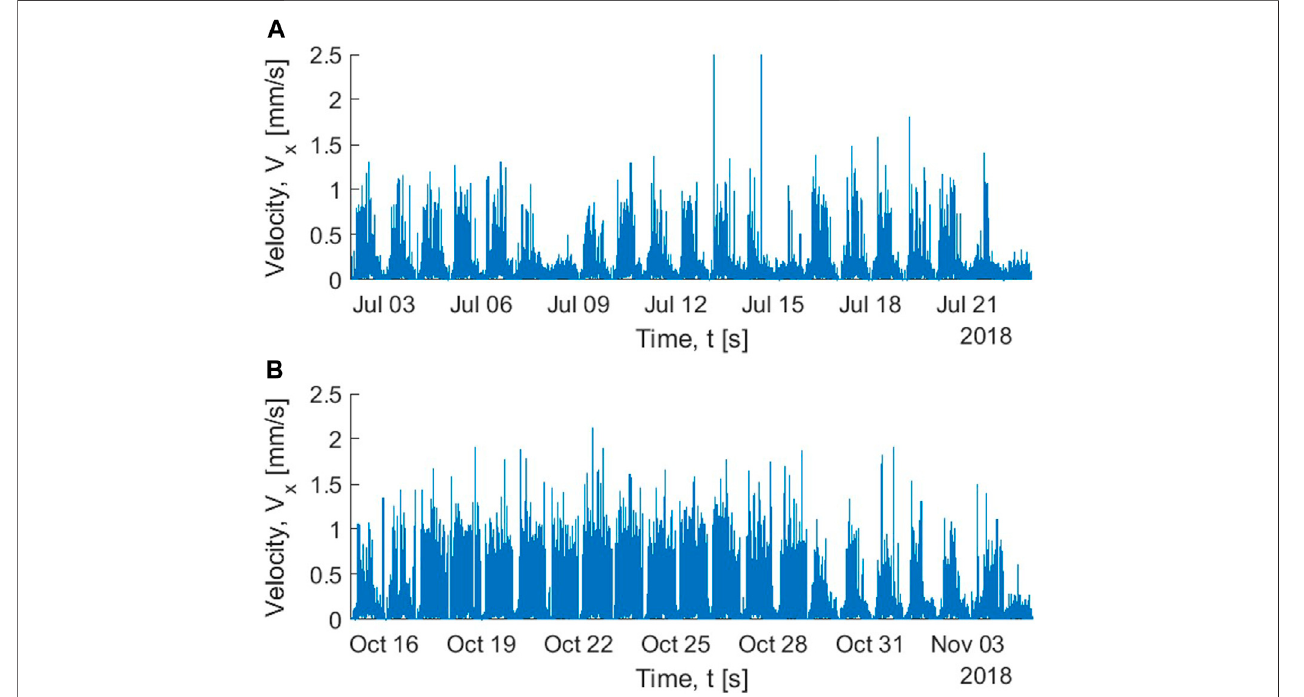
FIGURE6| One-minutepeakvibrationlevelsmeasuredinX-directionatabuildingnearabusstopfortheperiods (A) 2/7/2018 ‒ 23/7/2018,and (B) 15/10/2018 ‒ 5/11/2018.